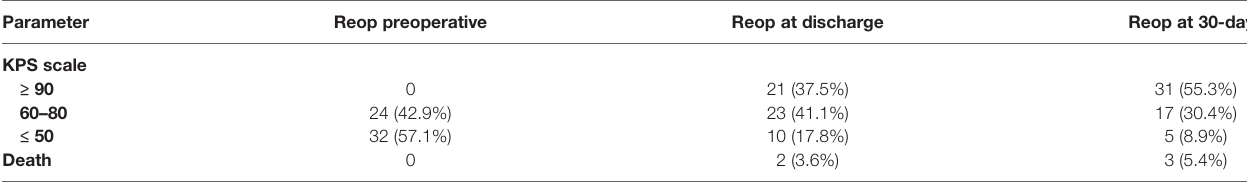
TABLE 2 | Clinical outcomes of unplanned reoperation after glioma surgery.